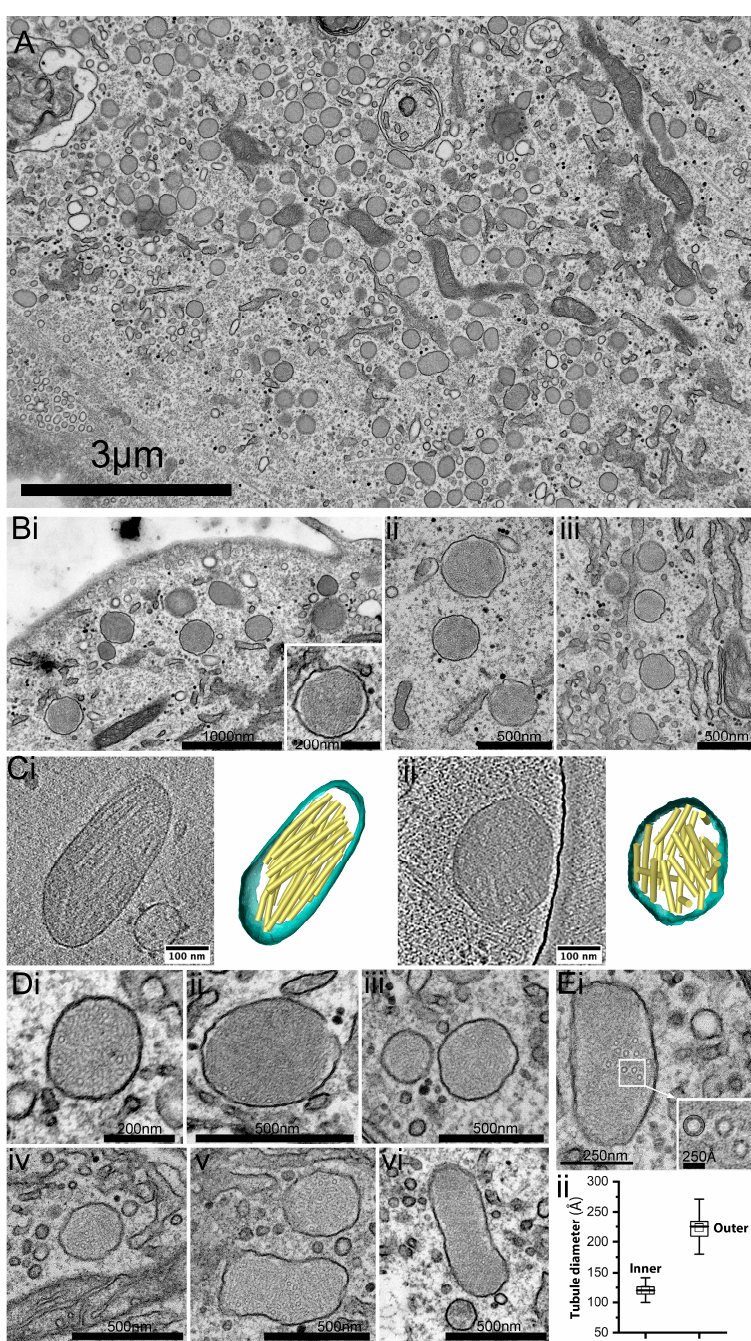
Figure 3. HCMEC D contain numerous rounded WPBs. ( A ) A representative en-face thin section (~60 nm) transmission electron micrograph of a single HCMEC D showing numerous rounded WPBs as electron-dense, membrane-bound organelles within the cell cytoplasm. ( B ) Examples of rounded WPBs at higher magnification. ( Ci , ii ) 3D reconstructions of tubule structures in shortened (left) and rounded (right WPBs) in HCMEC via cryo-ET. ( Di – iii ) Examples of WPBs showing tubule-like structures embedded within the luminal material. ( Ei , ii ) Quantification of the inner and outer dimensions of tubule-like structures (n = 80 tubules). Whisker box; 25–75% range, inner box; mean, error bars; range 1.5IQR, horizontal bar; median. HCMEC; human cardiac microvascular endothelial cells ( D ; dilated cardiomyopathy). WPBs; Weibel–Palade bodies. Cryo-EM; cryo-electron microscopy. Cryo-ET; cryo-electron tomography.